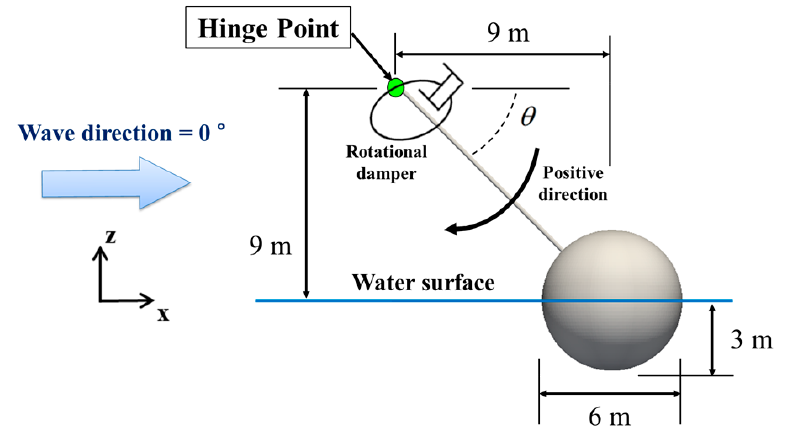
Figure 6. Model description of a spherical float.